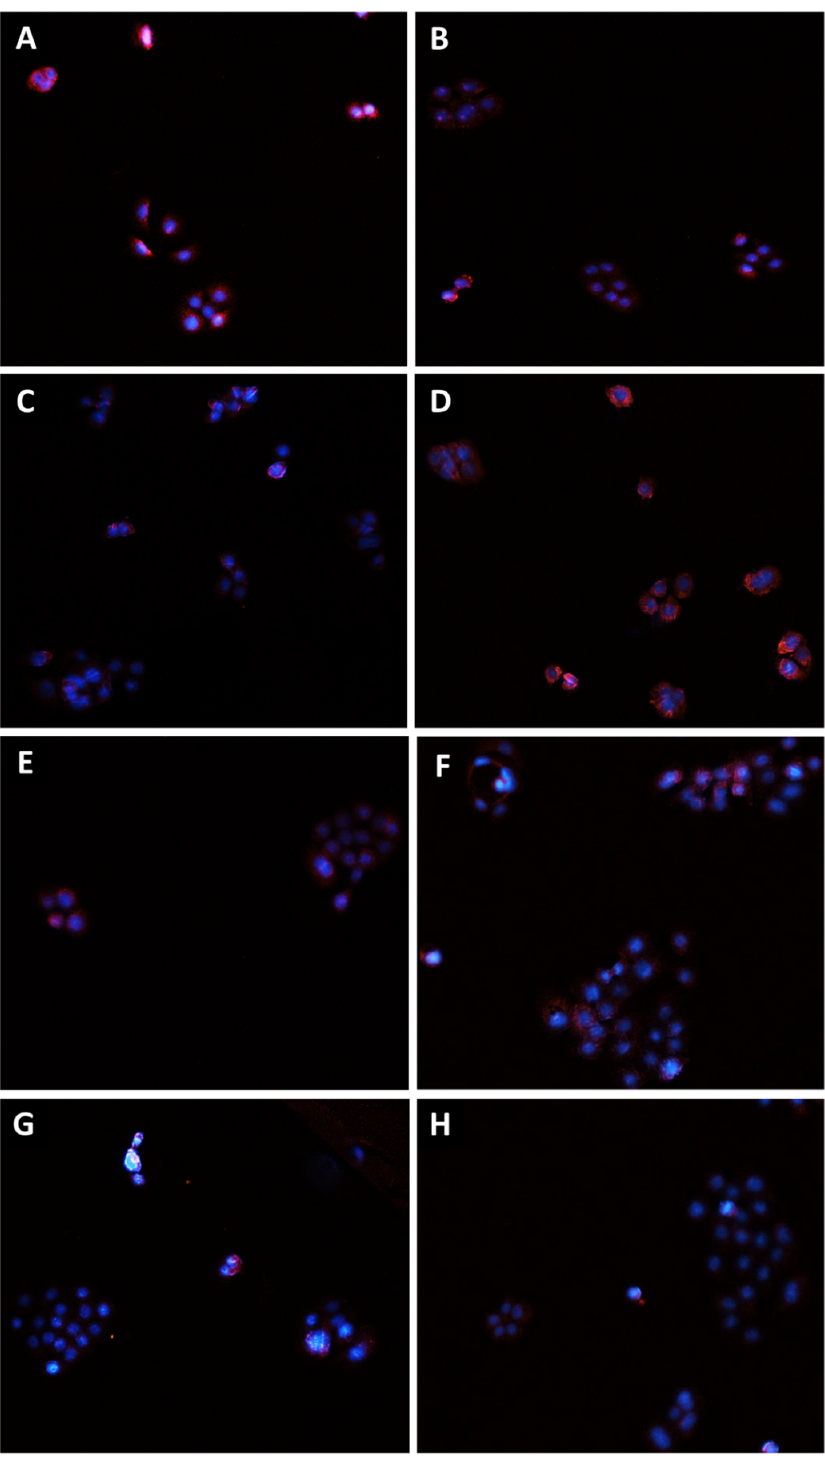
Figure 10. Modulation of MRP1 transporter expression in Bx-PC3 cells detected after 4 h exposure and 72 h recovery time. Representative images obtained at immunofluorescence analysis. Original magnification: 10×. ( A ) Control; ( B ) sorafenib 10 µg/mL; ( C ) MK571 1 µg/mL; ( D ) MK571 1 µg/mL + sorafenib 10 µg/mL; ( E ) β -caryophyllene 10 µg/mL; ( F ) β -caryophyllene 10 µg/mL + sorafenib 10 µg/mL; ( G ) β -caryophyllene oxide 10 µg/mL; ( H ) β -caryophyllene oxide 10 µg/mL + sorafenib 10 µg/mL.